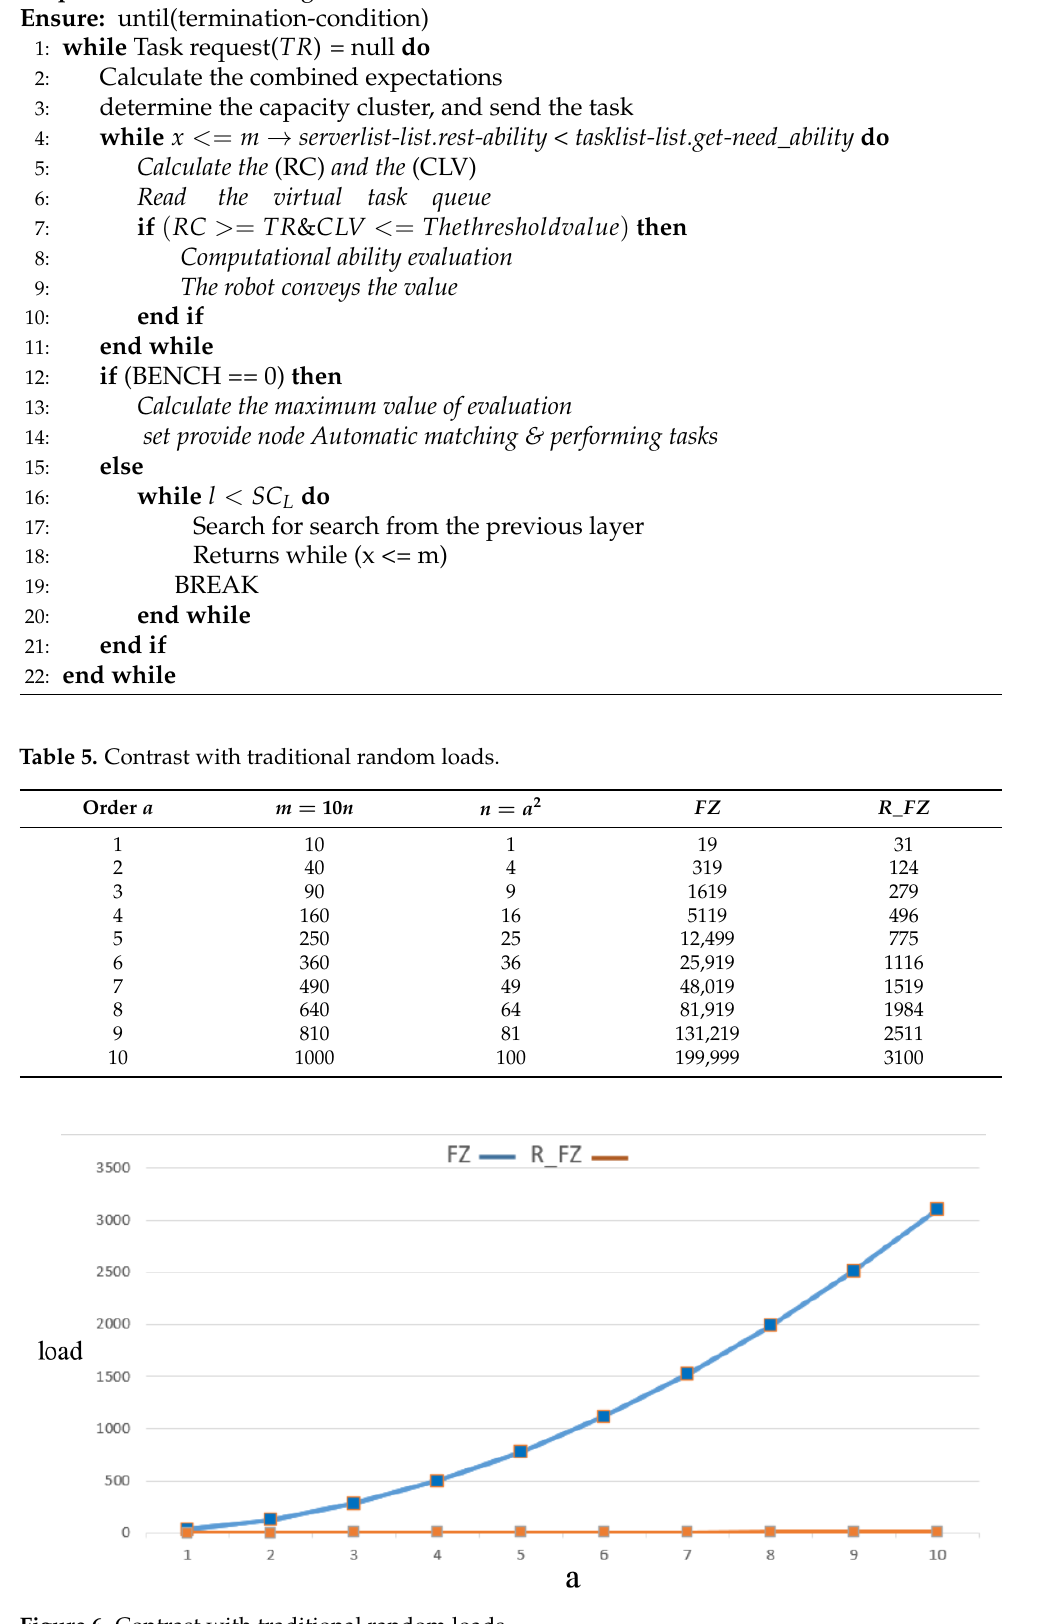
Figure 6. Contrast with traditional random